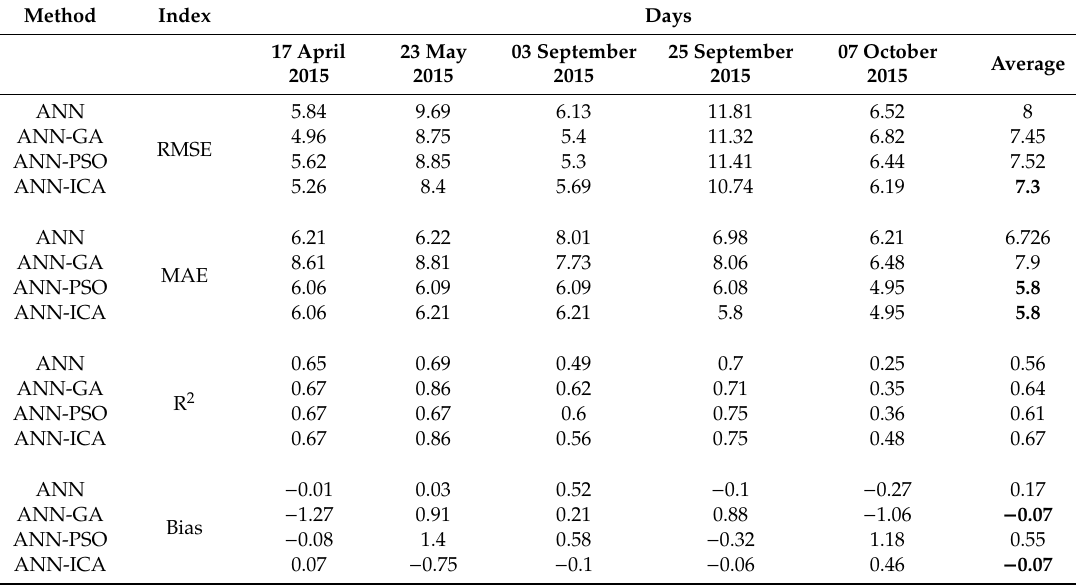
Table 6. Performance of the models using statistical indices-based evaluations for five heavy daily precipitation events over Northeast Austria.